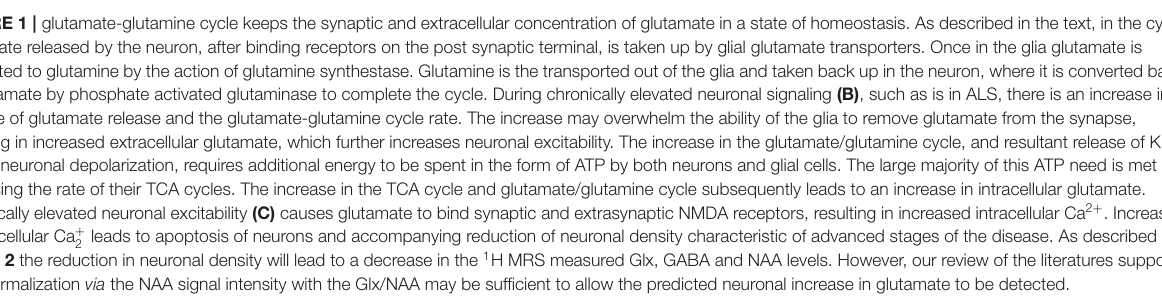
FIGURE 1 | glutamate-glutamine cycle keeps the synaptic and extracellular concentration of glutamate in a state of homeostasis. As described in the text, in the cycle glutamate released by the neuron, after binding receptors on the post synaptic terminal, is taken up by glial glutamate transporters. Once in the glia glutamate is converted to glutamine by the action of glutamine synthestase. Glutamine is the transported out of the glia and taken back up in the neuron, where it is converted back to glutamate by phosphate activated glutaminase to complete the cycle. During chronically elevated neuronal signaling (B) , such as is in ALS, there is an increase in the rate of glutamate release and the glutamate-glutamine cycle rate. The increase may overwhelm the ability of the glia to remove glutamate from the synapse, resulting in increased extracellular glutamate, which further increases neuronal excitability. The increase in the glutamate/glutamine cycle, and resultant release of K + due to neuronal depolarization, requires additional energy to be spent in the form of ATP by both neurons and glial cells. The large majority of this ATP need is met by increasing the rate of their TCA cycles. The increase in the TCA cycle and glutamate/glutamine cycle subsequently leads to an increase in intracellular glutamate. Chronically elevated neuronal excitability (C) causes glutamate to bind synaptic and extrasynaptic NMDA receptors, resulting in increased intracellular Ca 2 + . Increases in intracellular Ca + 2 leads to apoptosis of neurons and accompanying reduction of neuronal density characteristic of advanced stages of the disease. As described in Figure 2 the reduction in neuronal density will lead to a decrease in the 1 H MRS measured Glx, GABA and NAA levels. However, our review of the literatures supports that normalization via the NAA signal intensity with the Glx/NAA may be sufficient to allow the predicted neuronal increase in glutamate to be